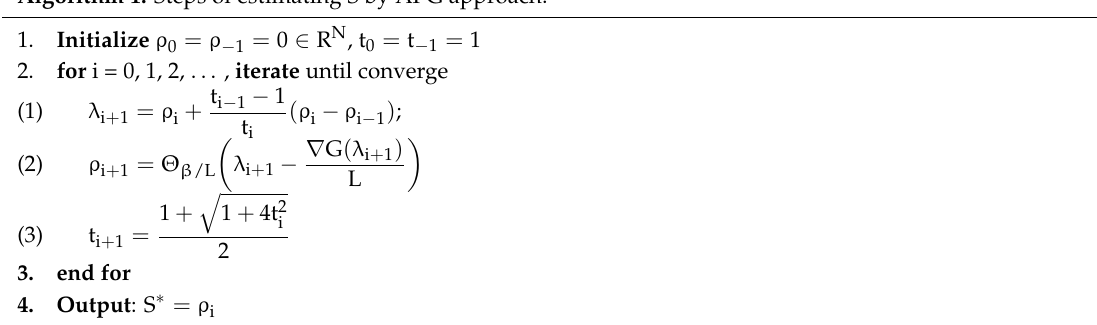
Algorithm 1. Steps of estimating S by APG approach.